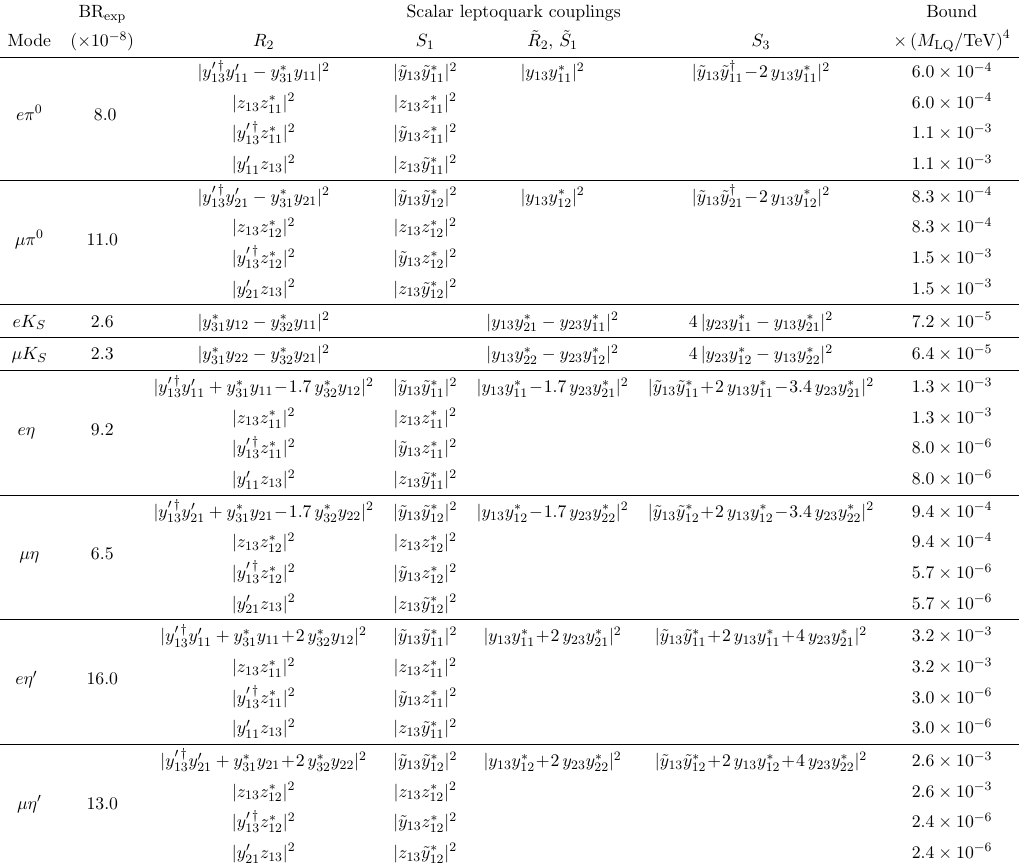
Table 1 . 90% C.L. bounds on scalar leptoquark couplings from (cid:28) ! ‘ P